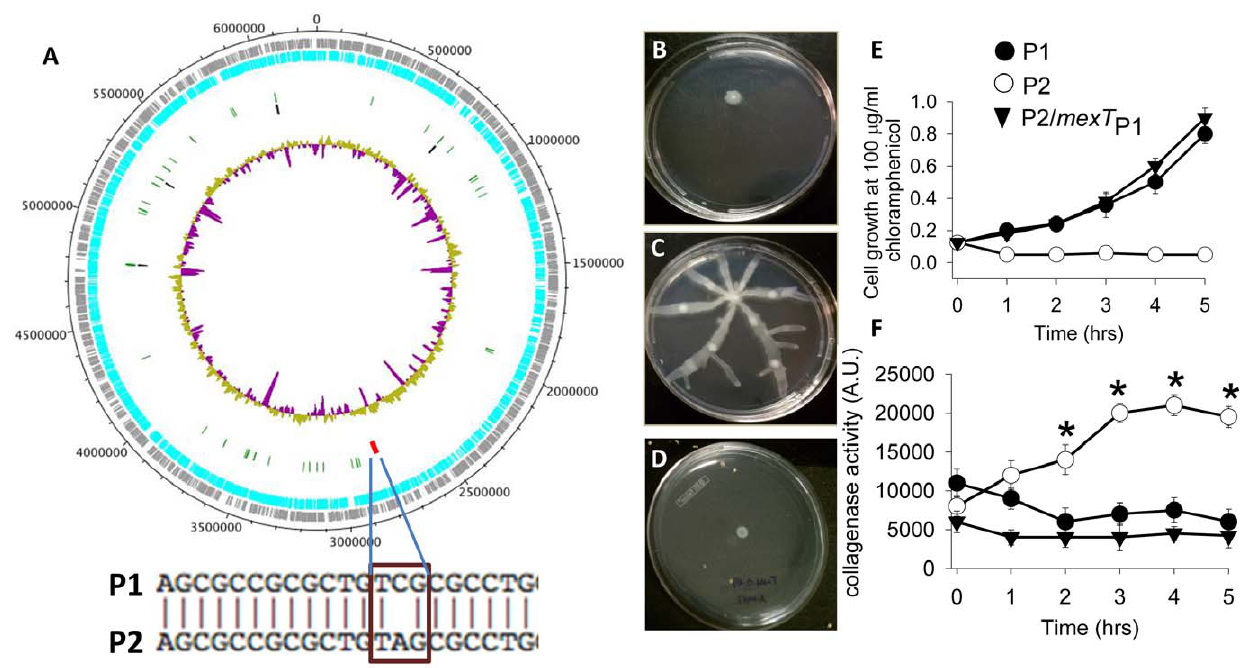
Figure 6. SNP mutation in MexT is responsible for P2 phenotype. (A) Genome DNA sequence comparative map of P. aeruginosa MPAO1-P1 and MPAO1-P2 at the DSM-1707 backbone annotated with the MexT locus. Grey and teal bands: annotated coding regions; red tick: location of MexT locus; green ticks: tRNAs; black ticks: rRNAs; inner circle GC content. (B–D) swarming motility in (B) MPAO1-P1 (P1), (C) MPAO1-P2 (P2), and (D) MPAO1-P2 in which mexT was replaced by mexT gene amplified from MPAO1-P1 (P2/ mexT P1 ). (E) Growth curves at 100 m g/ml chloramphenicol demonstrating acquisition of chloramphenicol resistance in P2/ mexT P1. (F) Collagenase activity measured by fluorescence of fluorescent labeled gelatin as a substrate. n=6, *p , 0.01. Results are representative of 3 independent experiments.